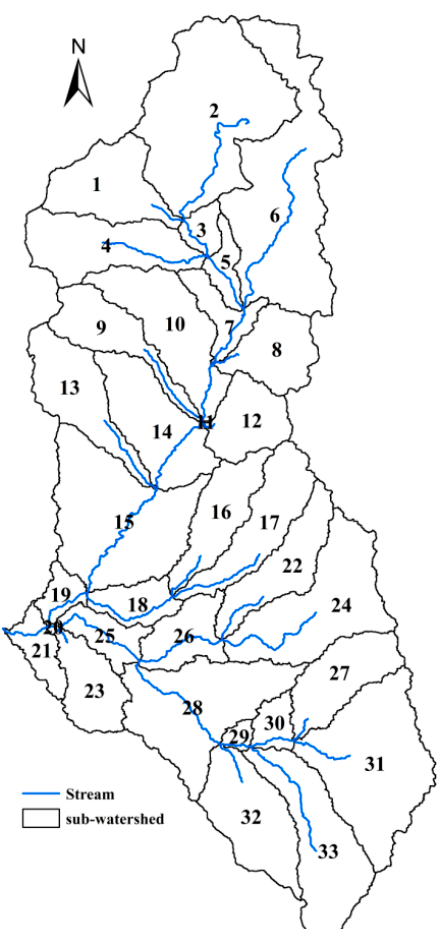
Figure 3. Map showing the sub-watersheds in the Upper Honganjian watershed.